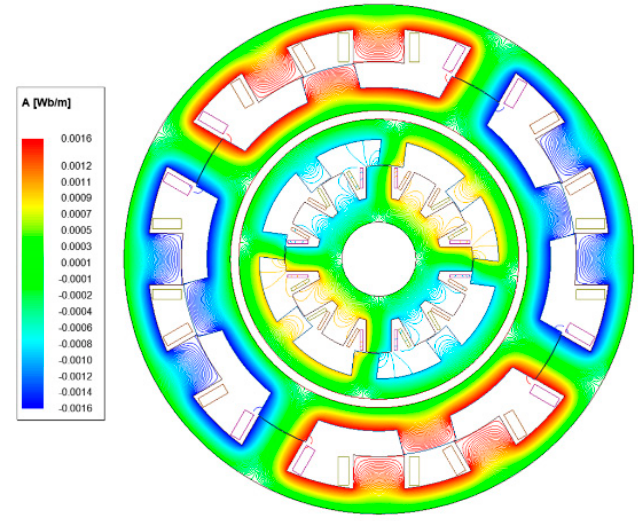
Figure 3. 2D magnetic-field-line distribution of DSRM.